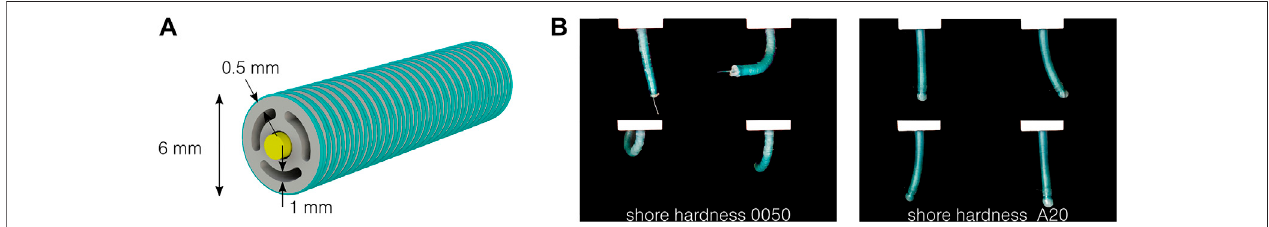
FIGURE 1 | Design of the two-degree-of-freedom fl uidic actuator. (A) Cross-section of the actuator, composed of a silicone body in gray, a thread or endoscopic tool acting as a neutral fi ber in yellow, and fi ber reinforcement in green. (B) The actuator bends in every direction by pressurizing the different circumferential channels, here at 0.5 bar with two different silicones.